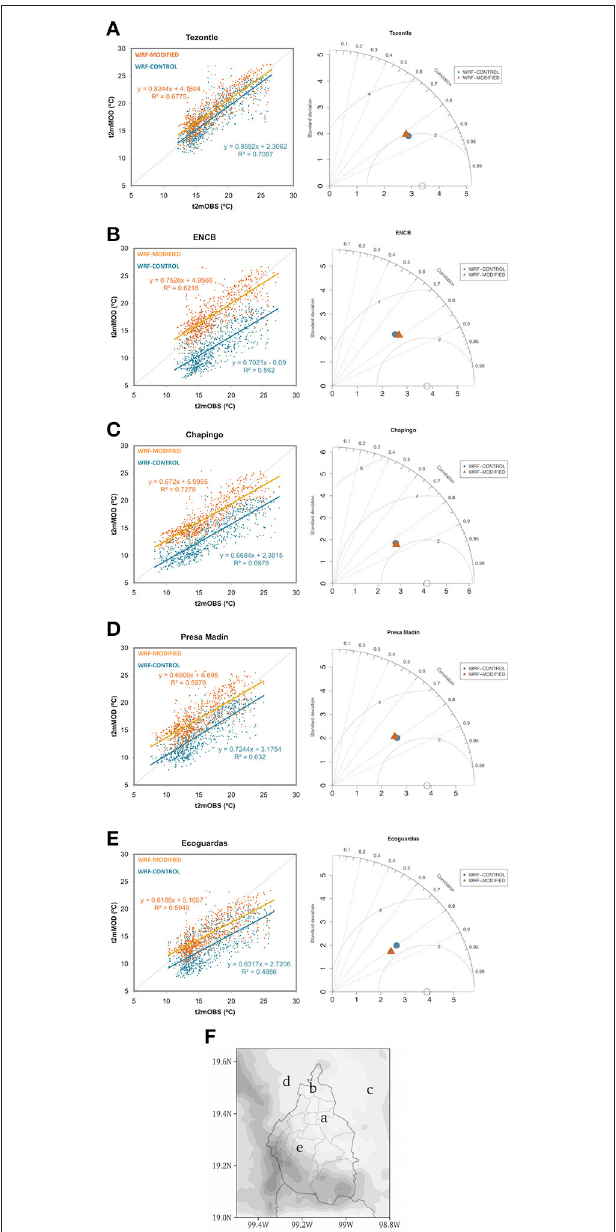
FIGURE 7 | (Left) Hourly air temperature dispersion at 2m ( ◦ C) in different regions of the MCMA (July 2014). Blue dots, WRF control; orange dots, modified WRF. Regression equations follow the same color scheme. (Right) The Taylor diagram (Taylor, 2001) (A) Tezontle, (B) ENCB, (C) Chapingo, (D) Presa Madín, (E) Ecoguardas, and (F) Location map for the analyzed points (A–E) .